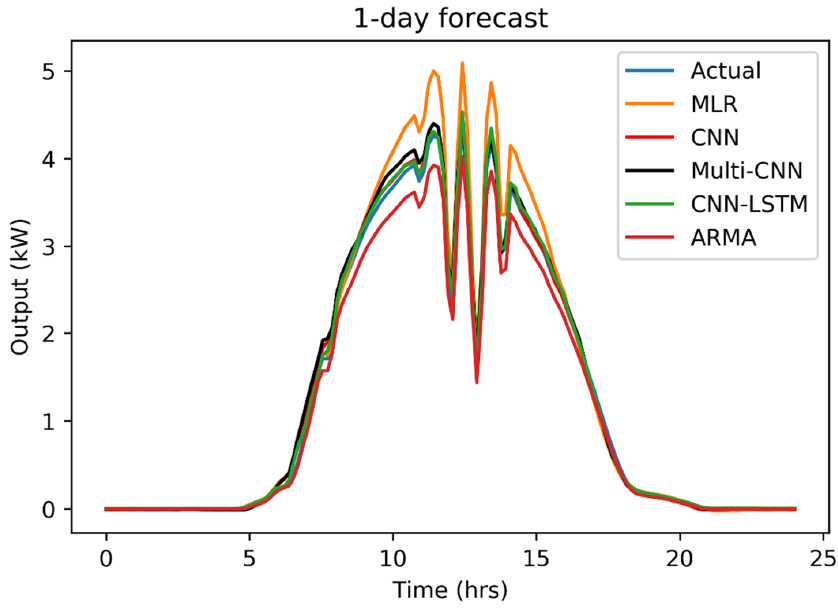
Figure 8. Comparison of different methods for the 1-day forecast (summer).